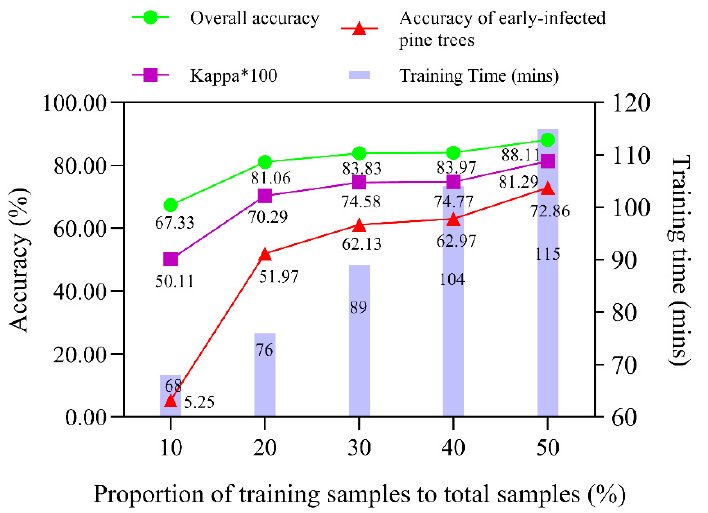
Figure 14. Classification performance of the 3D-Res CNN model using different training sample sizes.